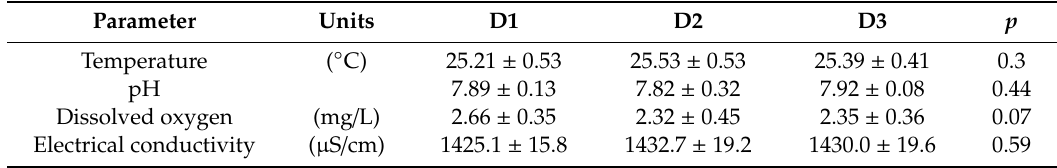
Table 2. Physical–chemical water parameters in the hydroponic units (mean ± SD) during the experimental period (60 days).